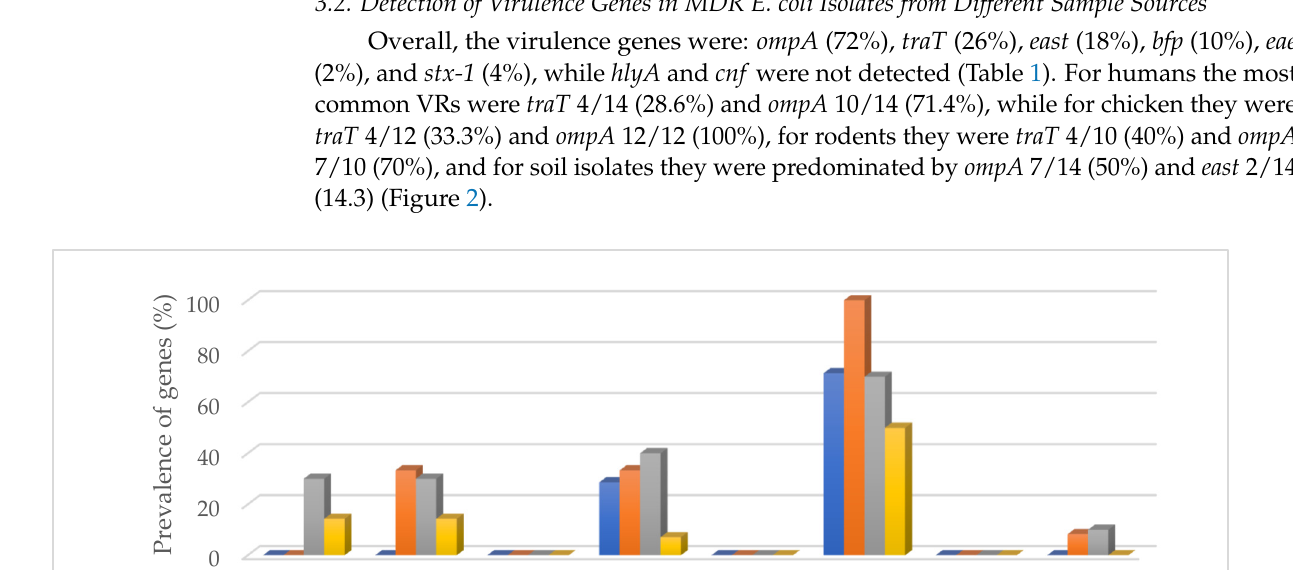
Figure 1. Occurrence of resistance genes in MDR E. coli isolates from different sample types.